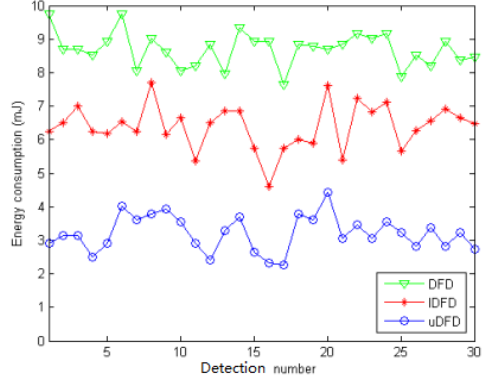
Figure 14. Energy consumption of each detection under 40 working node conditions.